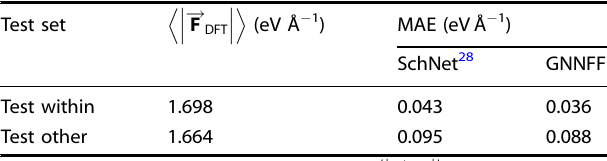
Table 1. Comparison of GNNFF and SchNet Cartesian force components predictive accuracy of the ISO17 database.